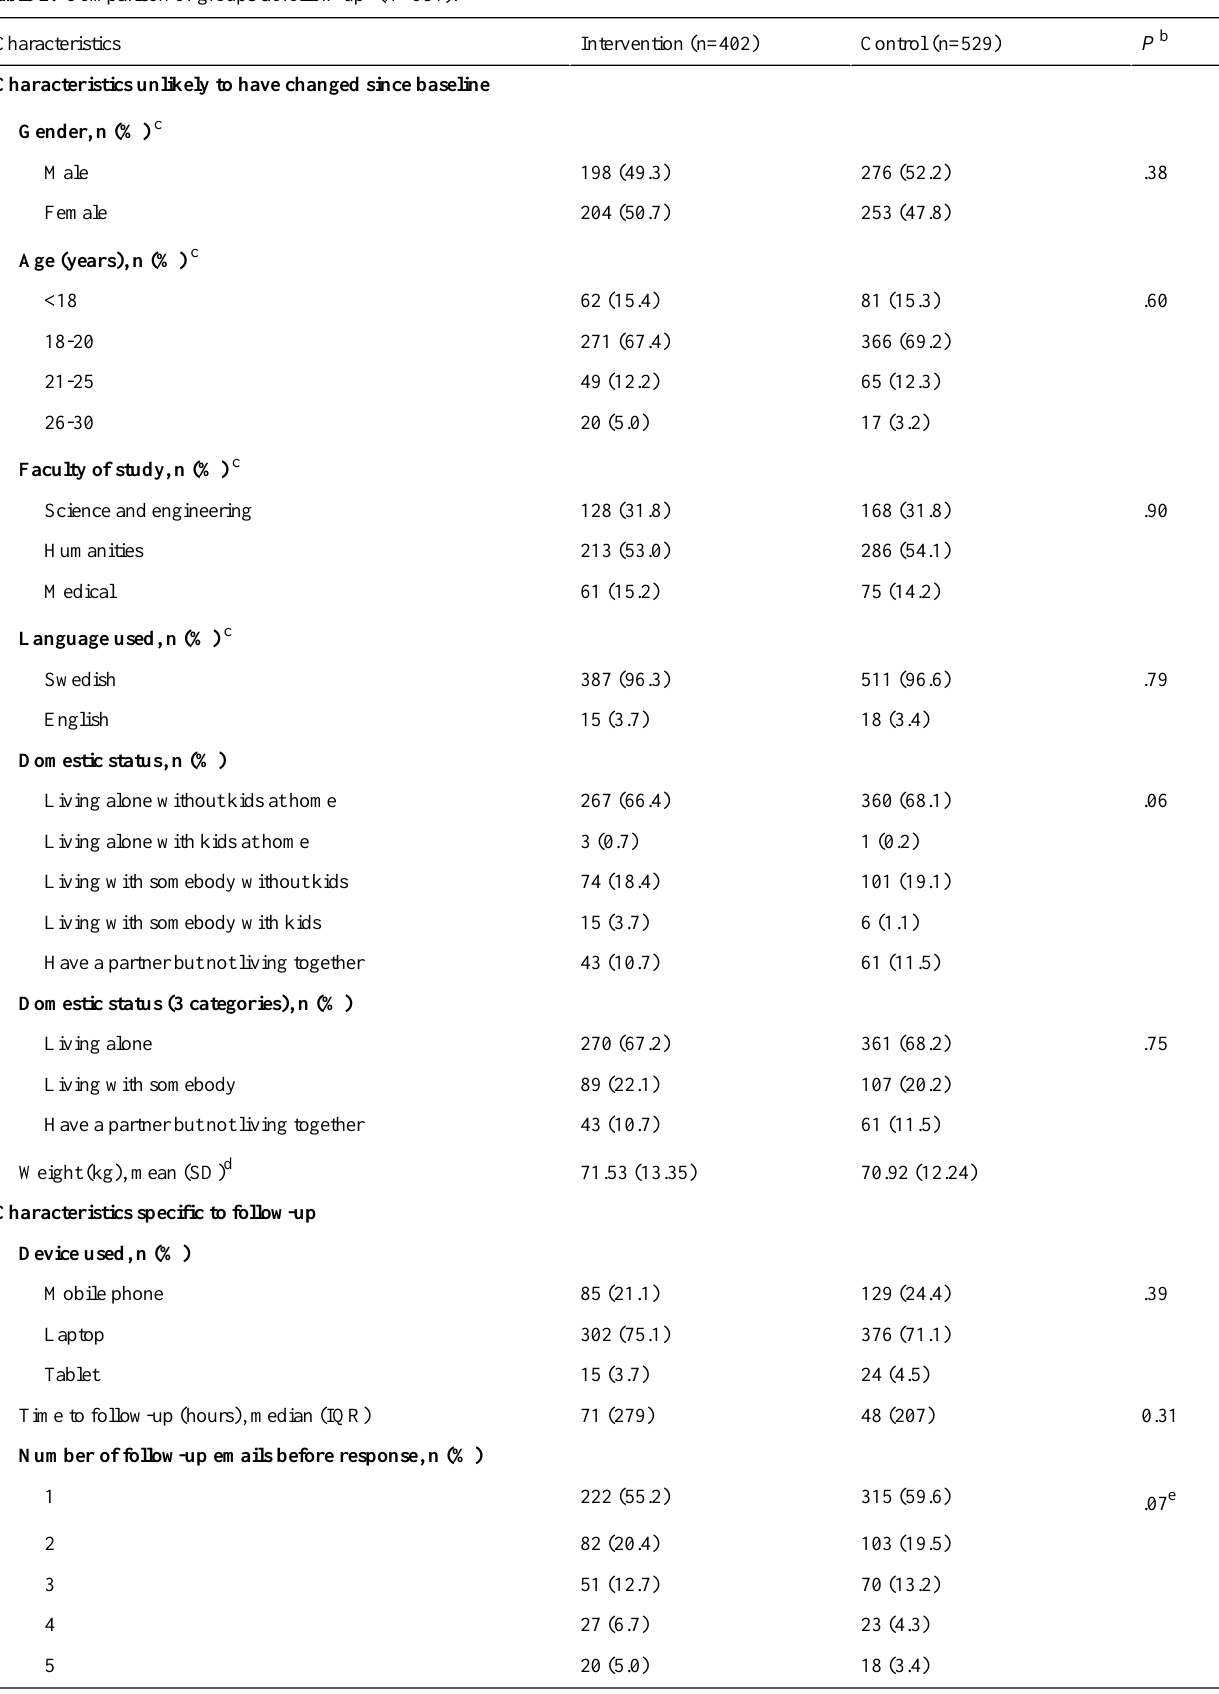
Table 2. Comparison of groups at follow-up a (N=931).